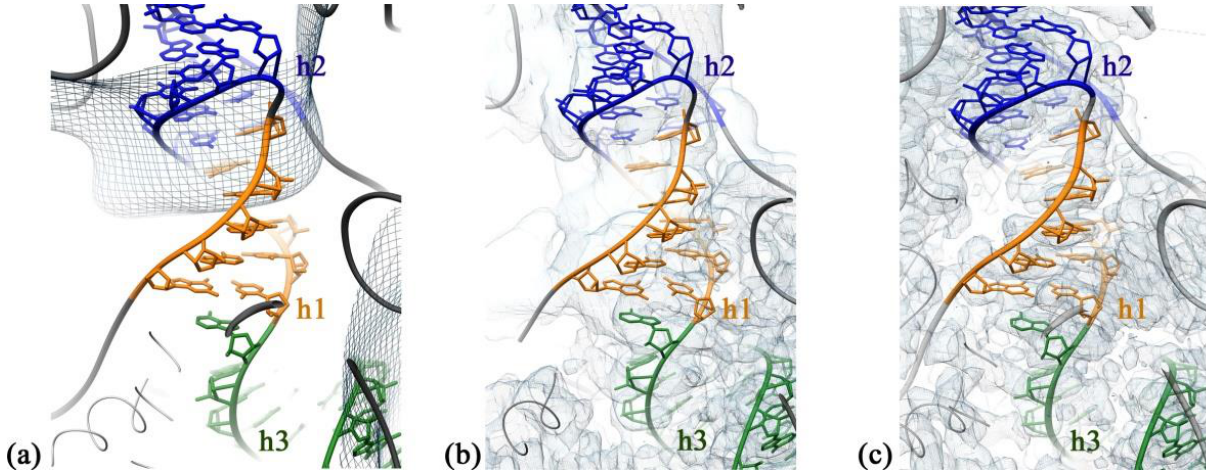
Figure 3. Сentral pseudoknot region in the cryo -EM structure of class A, D, and F intermediates. ( a ) Figure 3. Central pseudoknot region in the cryo-EM structure of class A, D, and F intermediates. ( a ) The superposition The superposition of the atomic model built for the reference wild-type 30S subunit and сryo -EM of the atomic model built for the reference wild-type 30S subunit and с ryo-EM density map for class A. The densities for density map for class A. The densities for helices 1 and 3 are completely missing and helix 2 is helices 1 and 3 are completely missing and helix 2 is smeared. ( b ) Atomic model and с ryo-EM density map for class D. Helices h1, h2, h3 are color-coded. ( c ) Atomic model and с ryo-EM density map for class smeared. ( b ) Atomic model and сryo -EM density map for class D. Helices h1, h2, h3 are col- or-coded. ( c ) Atomic model and сryo -EM density map for class F.